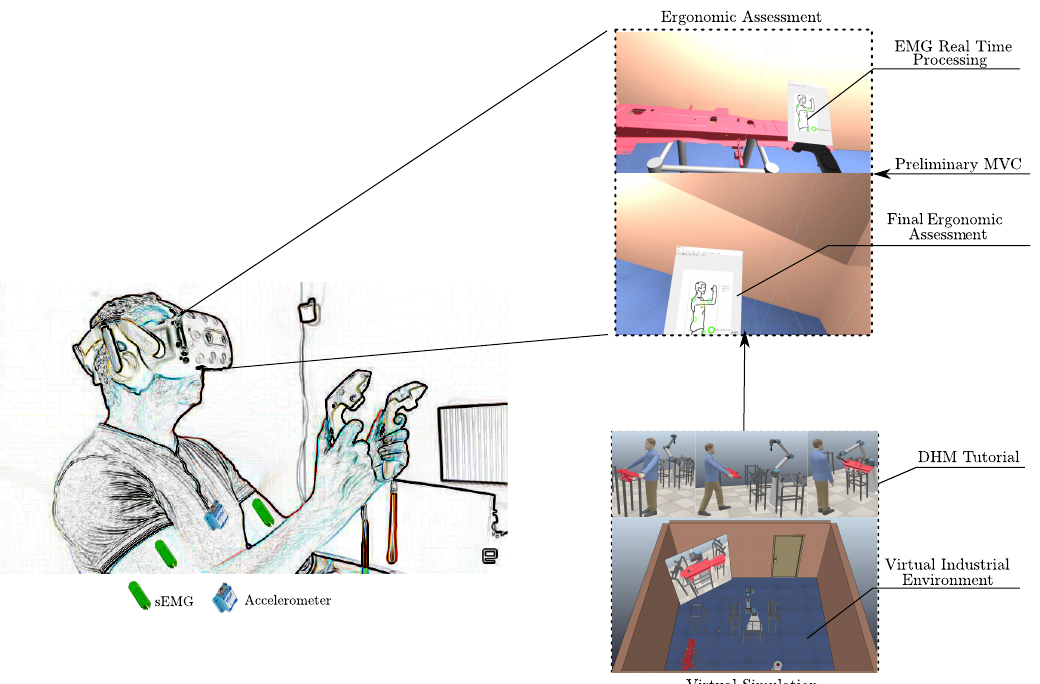
Figure 1. A schematic representation of the system architecture. On the left, an image of a real scenario: the user wears the wearable sensors (i.e., sEMG and accelerometer) and VR devices (i.e., headset and controllers). On the bottom–right, the block of “Virtual Simulation”, composed of a photosequence of the DHM tutorial ( top ) and an image of the virtual environment ( bottom ). On the top-right, the block of the “Ergonomic Assessment” with the input data: the virtual simulation and the “Preliminary MVC”. In the block on the top, there is an image in virtual simulation with the “EMG Real Time Processing” and on the bottom is an image of the “Final Ergonomic